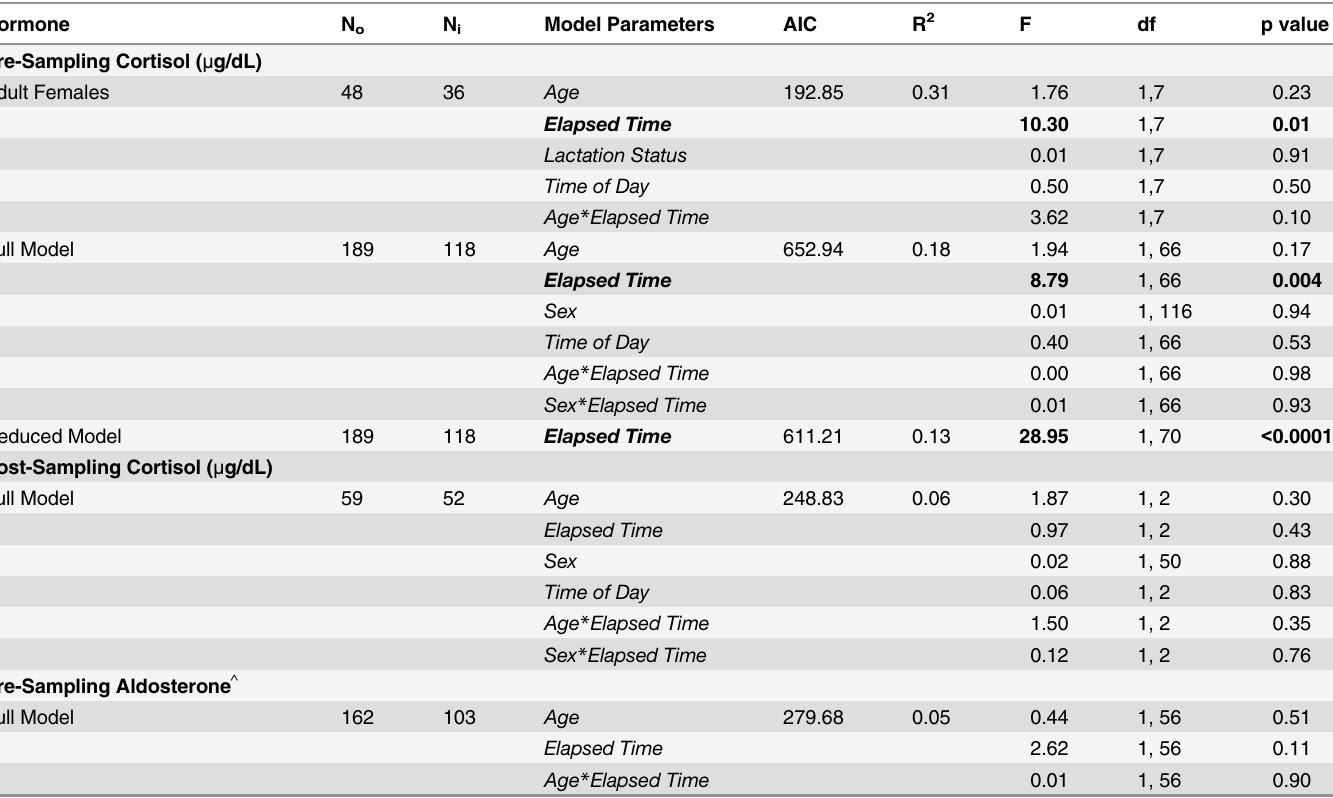
Table 2. Linear Mixed Models.